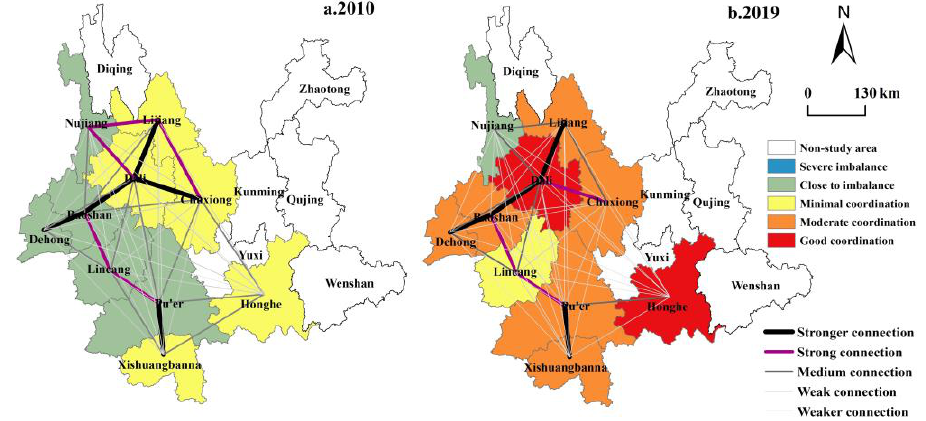
Figure 6. The spatial distribution of coupling coordination degree of tourism industry and urbani- zation.